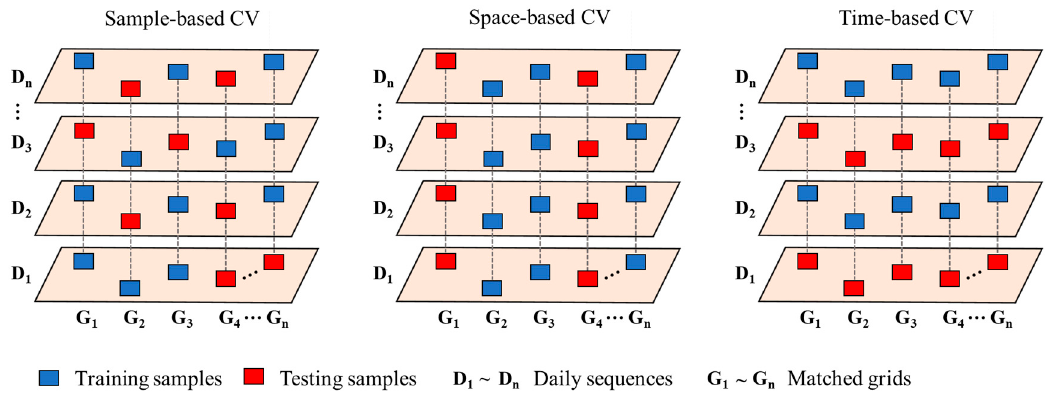
Figure 3. Cross-validation methods.